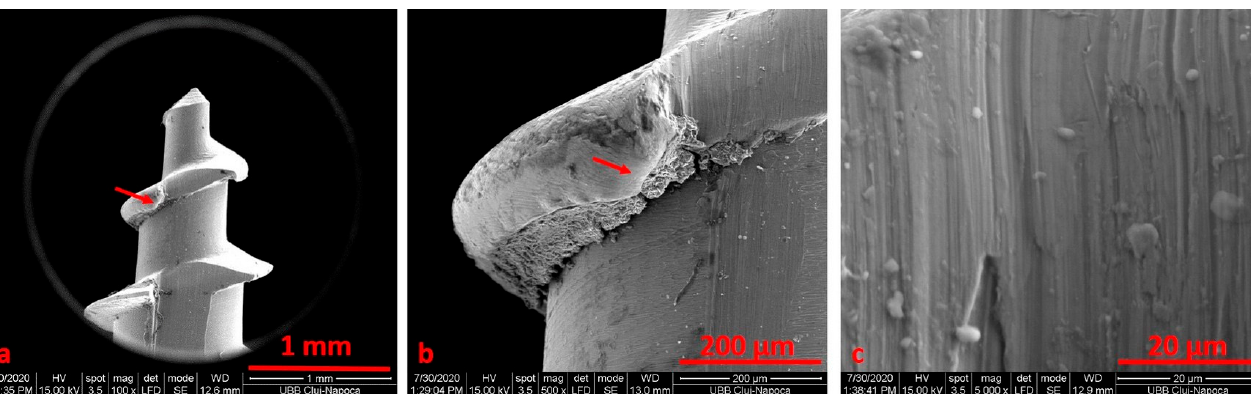
Figure 4. SEM image for the TADs (patient 1) before electrochemical treatment using Ringer’s Solution at ×100 ( a ), ×500 ( b ), ×5000 ( c ) magnification.